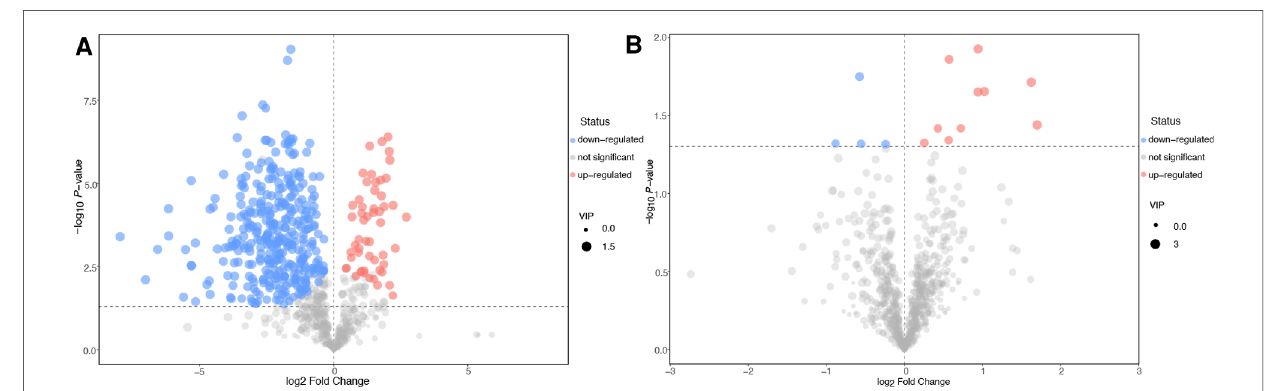
FIGURE 4 Volcano plots of the differential metabolites. Control group vs. the non-VC group ( A ). Non-VC group vs. the VC group ( B ). The abscissa represents a multiple change (base-2 logarithm) of the metabolite and the ordinate denotes the P -value (negative base-10 logarithm). The size of the dots indicates the VIP value in the OPLS-DA model. The upregulated metabolites are marked in red, downregulated metabolites in blue, and those with no signi fi cant difference shown as